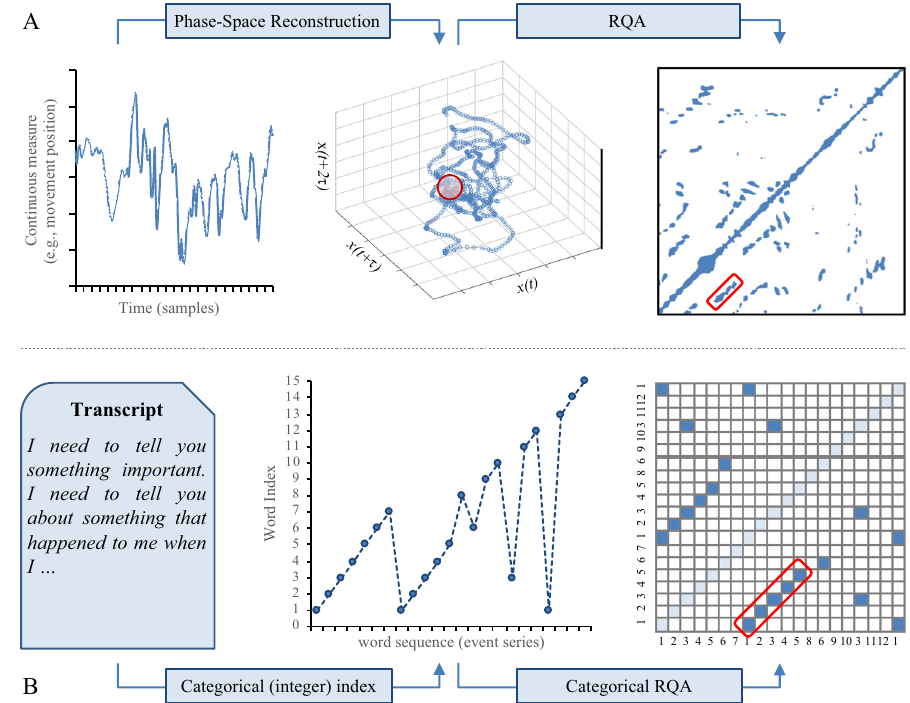
Fig. 3 Illustration of recurrence quanti fi cation analysis (RQA) procedures. A Illustrates the procedures involved in performing Recurrence Quanti fi cation Analysis (RQA) on continuous data. First, phase space reconstruction or PSR is employed to embed a continuous time-series measure as a trajectory in an n - dimensional phase space. A radius threshold (red circle) is then employed to determine recurrent states, which are plotted on a two-dimensional recurrence plot or RP (blue points correspond to recurrent states). B Illustrates the procedures involved in conducting categorical RQA (catRQA) on transcript data. First the transcription is coded as an integer number sequence, where each word in the transcription is represented by an integer value starting from word 1 to n (i.e., ‘ I ’ = 1, ‘ need ’ = 2, ‘ to ’ = 3 … ‘ when ’ = 12.). From this categorical data series an RP is then generated indicating recurrent states. For both continuous RQA and catRQA , the main diagonal or line of identity in the RP is ignored (removed). The quanti fi cation %REC corresponds to the percentage of recurrent points on the RP. The quanti fi cation Maxline corresponds to the longest diagonal sequence of recurrent points in a RP (red rectangles). See text for more